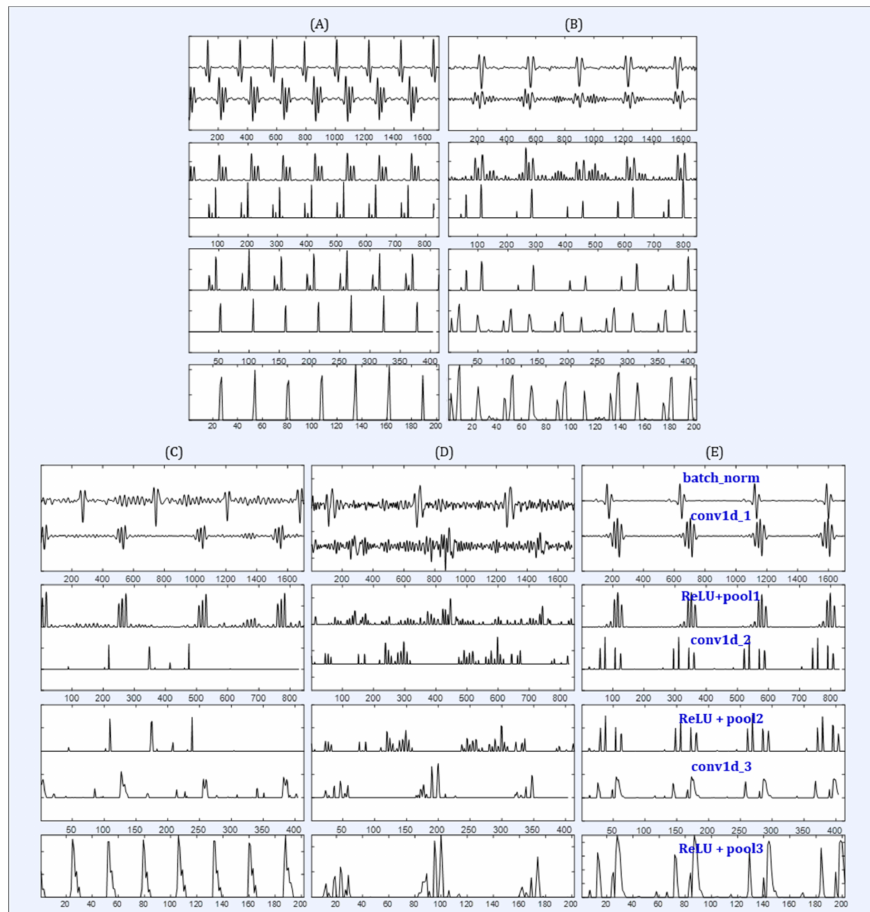
Figure 3. Example of the intermediate feature map of the designed deep learning SDN model for automatic classification of sleep disorders using a single-lead ECG signal. Intermediate feature maps of ( A ) INS, ( B ) PLM, ( C ) CNT, ( D ) RBD, and ( E ) NFE